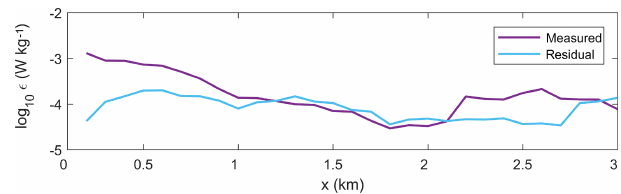
Figure 11. Comparison of interfacial layer-averaged (cid:15) over the length of Deep Cove, where (cid:15) was directly measured (purple) and derived from the residual stress divergence (blue).